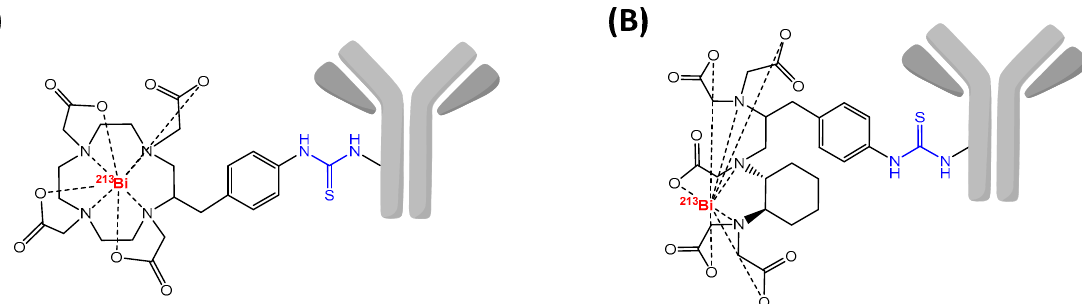
Figure 5. Schematic representation of 213 Bi-labeled radioimmunoconjugates based on p -SCN-Bn-DOTA ( A ) or p -SCN-Bn- CHX-A’’-DTPA ( B ).